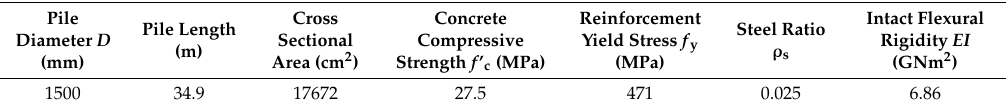
Table 3. Structural properties of bored pile.